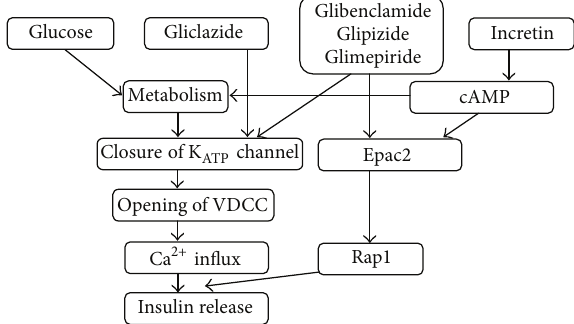
Figure 1: Convergence of the sulfonylurea and incretin pathways on insulinsecretionviaEpac2[14].cAMP:cyclicadenosinemonophos- phate; K ATP : ATP-dependent potassium channel; VDCC: voltage dependent calcium channel; Epac2: exchange protein activated by cAMP 2; Rap1: Ras-like guanosine